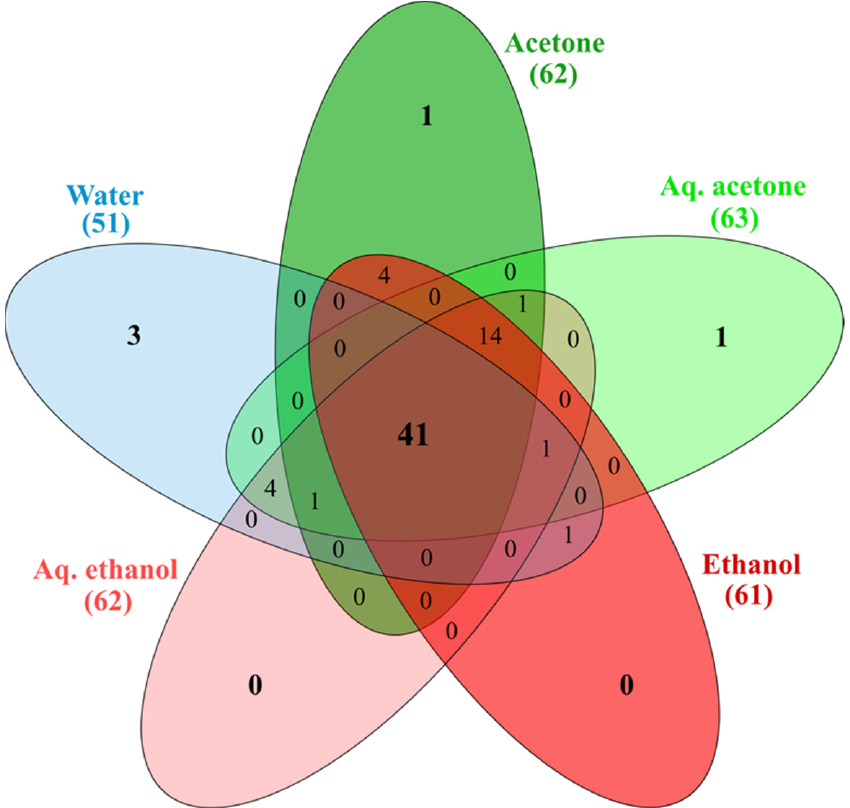
Figure 3. Venn diagram based on the number of identified compounds present in the different extracts from Cladium mariscus (sawgrass) seeds.